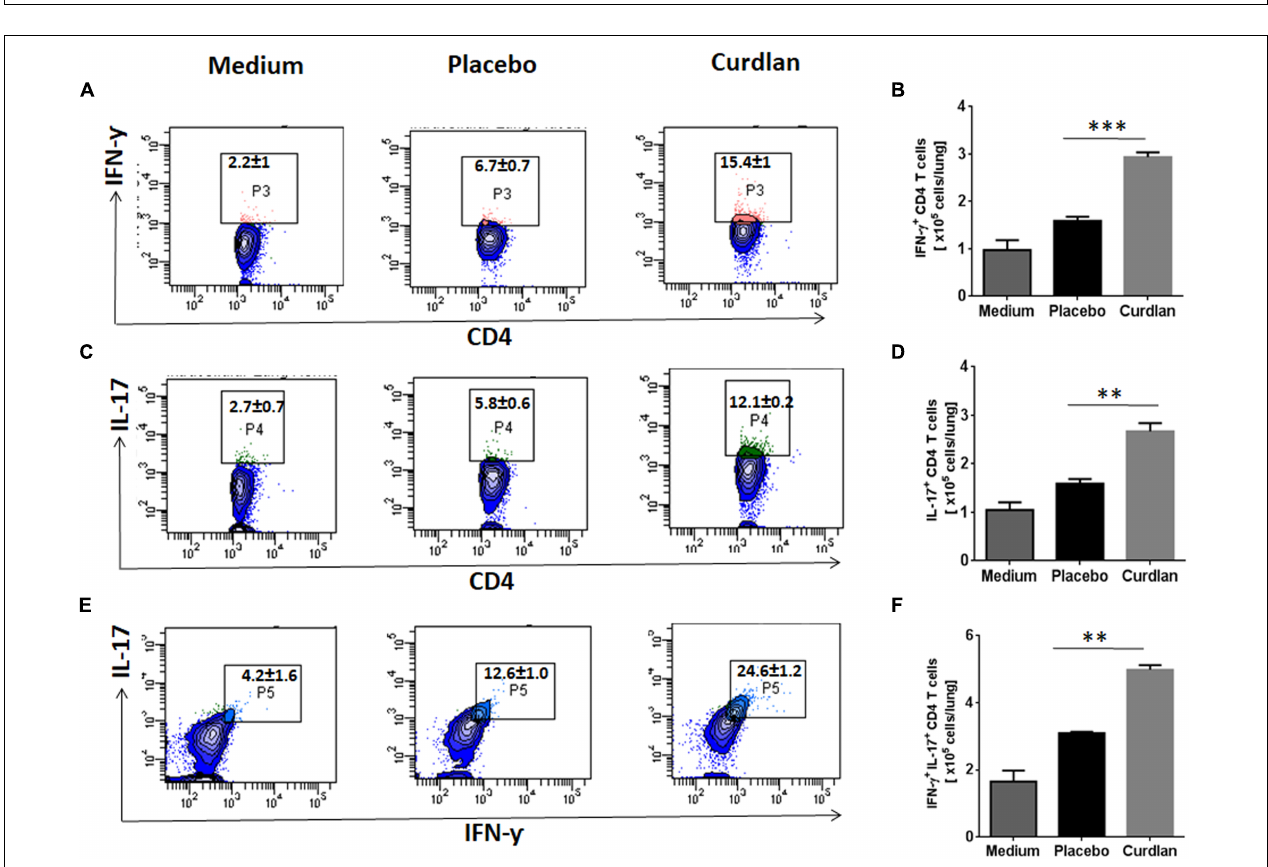
FIGURE 5 | Immunotherapy with curdlan elicits Th1 and Th17 immune response in Mtb challenged mice. Mtb infected mice were immunized with curdlan as described in legend to Figure 4 . After 7 weeks post infection, lung cells were isolated and cultured with PPD (25 µ g/ml) for 72 h. Later, intracellular staining was performed for examining the (A,B) IFN- γ + , (C,D) IL-17 + , and (E,F) IFN- γ + /IL-17 + cells by flow cytometry. Contour plots insets represent the percentage of IFN- γ + (pink colored), IL-17 + (green) and IFN- γ + /IL-17 + (light blue) cells gated on CD4 T cell population (indicated in blue) and bar graphs shows the absolute number of positive cells per lung. Data are shown as mean ± SD and are representative from two independent experiments. For each experiment, consisting of 4–5 mice/group, cells from individual mouse were plated in triplicate wells, and their average values were used to calculate the mean ± SD. ∗∗ p ≤ 0.01, ∗∗∗ p ≤ 0.001. Medium, unstimulated cells; Placebo, Mtb infected mice administered with PBS; Curdlan, Mtb infected mice treated with curdlan.